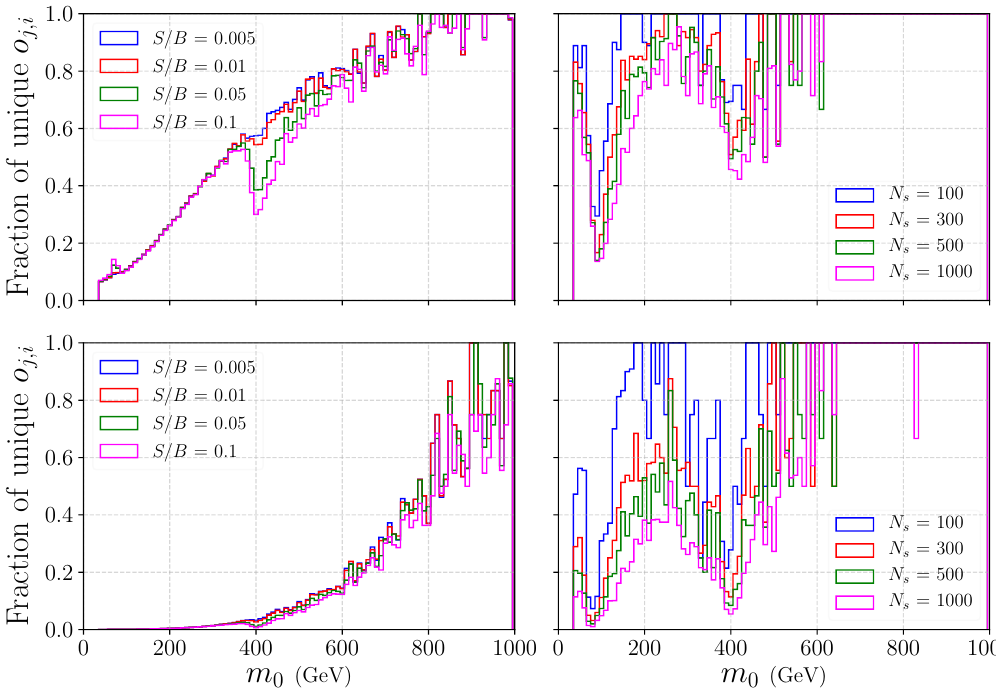
Figure 10 . Fraction of unique measurements in W 0 event samples, using all the mass basis ob- servables ( m 0 , m 1 =m 0 , m 2 =m 1 , k T , cos (cid:18) ) (top line) and only the pair ( m 0 , m 1 =m 0 ) (bottom line). On the left we show samples of 9 10 4 events consisting of di(cid:11)erent fractions of mixed signal ( W 0 ) (cid:2) and background (QCD) events, while on the right we show the results for di(cid:11)erent numbers of pure signal ( W 0 )